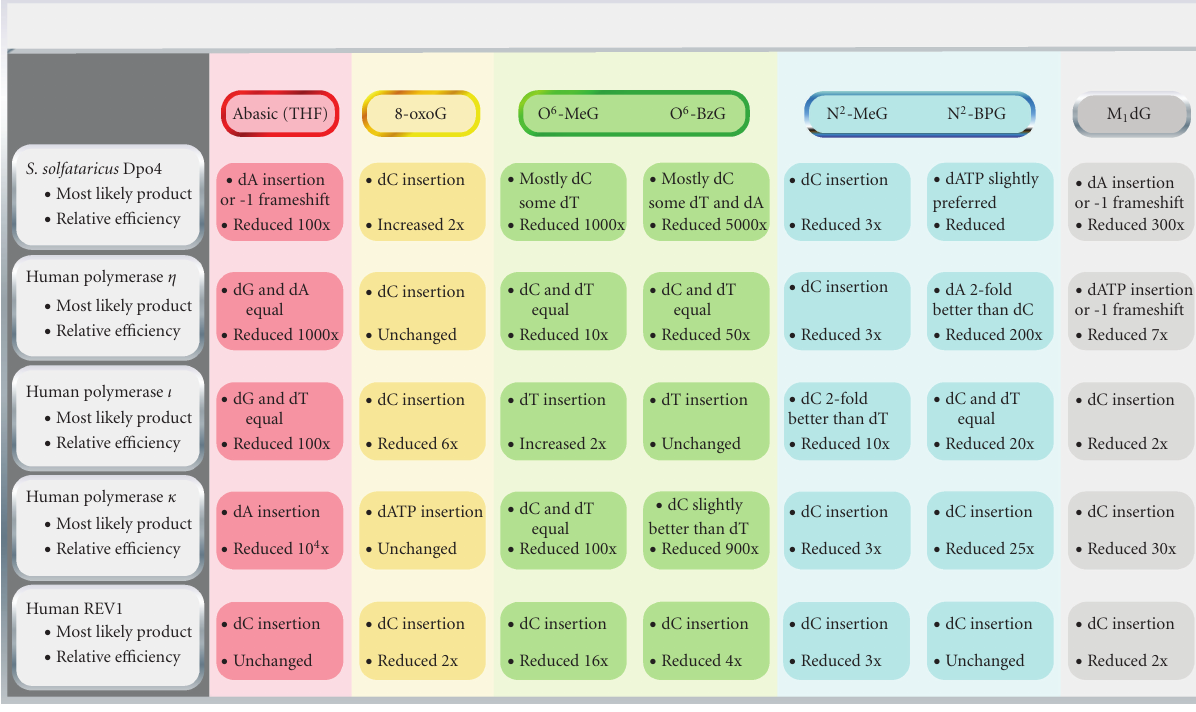
Figure 3: Summary of DNA adduct bypass capabilities for selected DNA polymerases. The table attempts to summarize the e ff ect of di ff erent DNA adducts on Y-family DNA polymerase catalytic e ffi ciency and makes note of the most likely dNTP insertion event for each lesion. Please see the main text for the corresponding